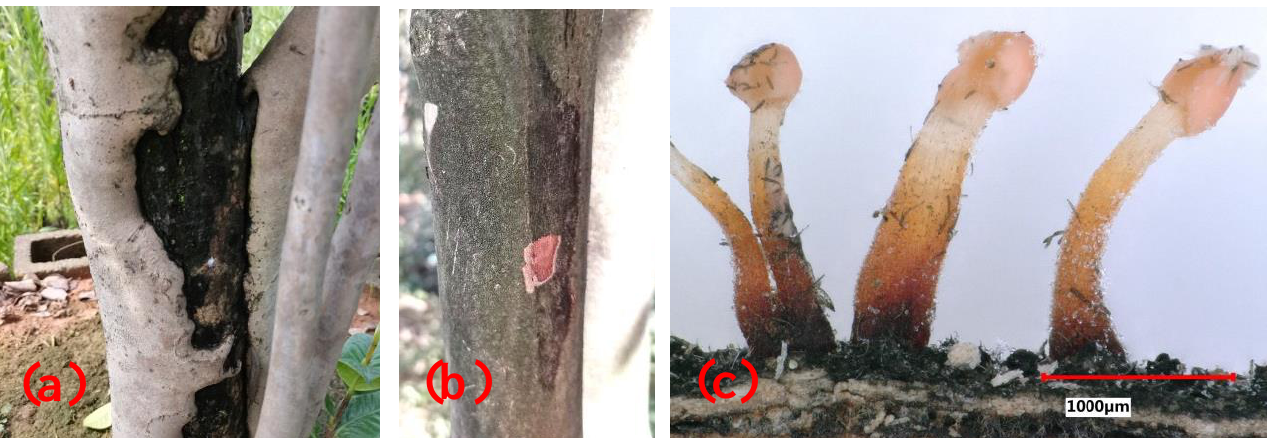
Forests 2022 , 13 , x FOR PEER REVIEW 6 of 9